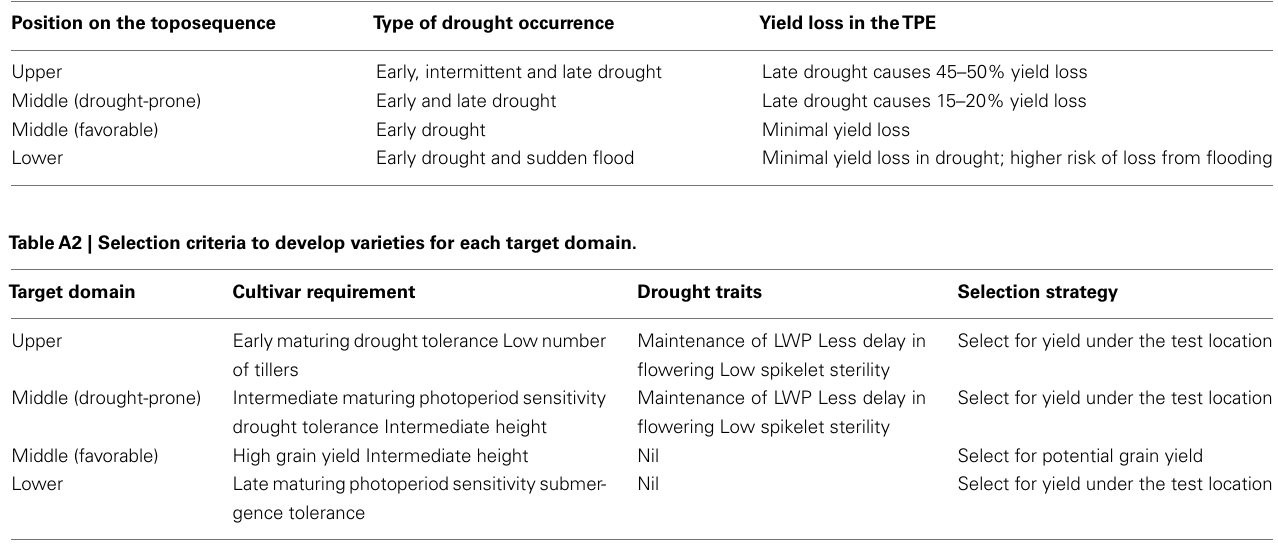
TableA1 | Use of the position on the toposequence to define the types of drought occurrence and the target population of environments (TPE) for the breeding program.